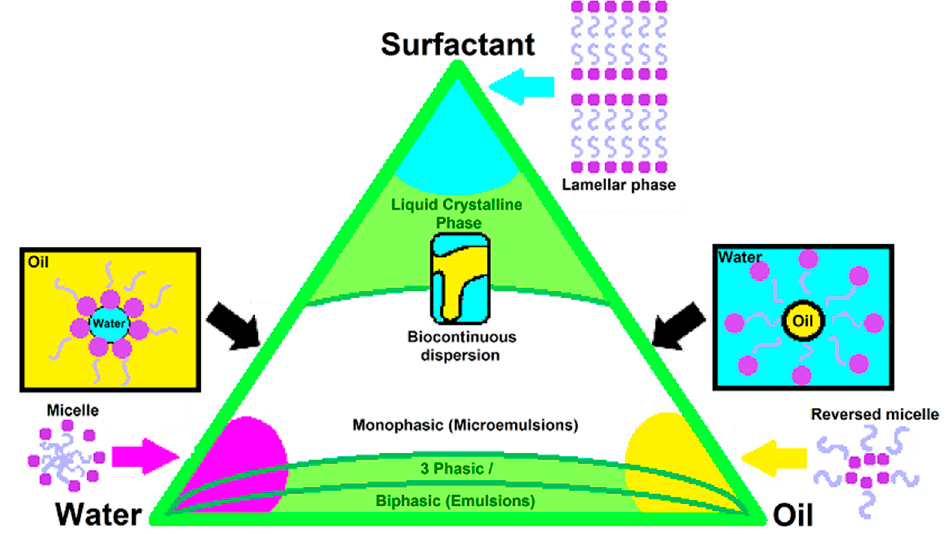
Figure 3. Hypothetical pseudo-ternary-phase diagram of phase behaviour exhibited by emulsions.